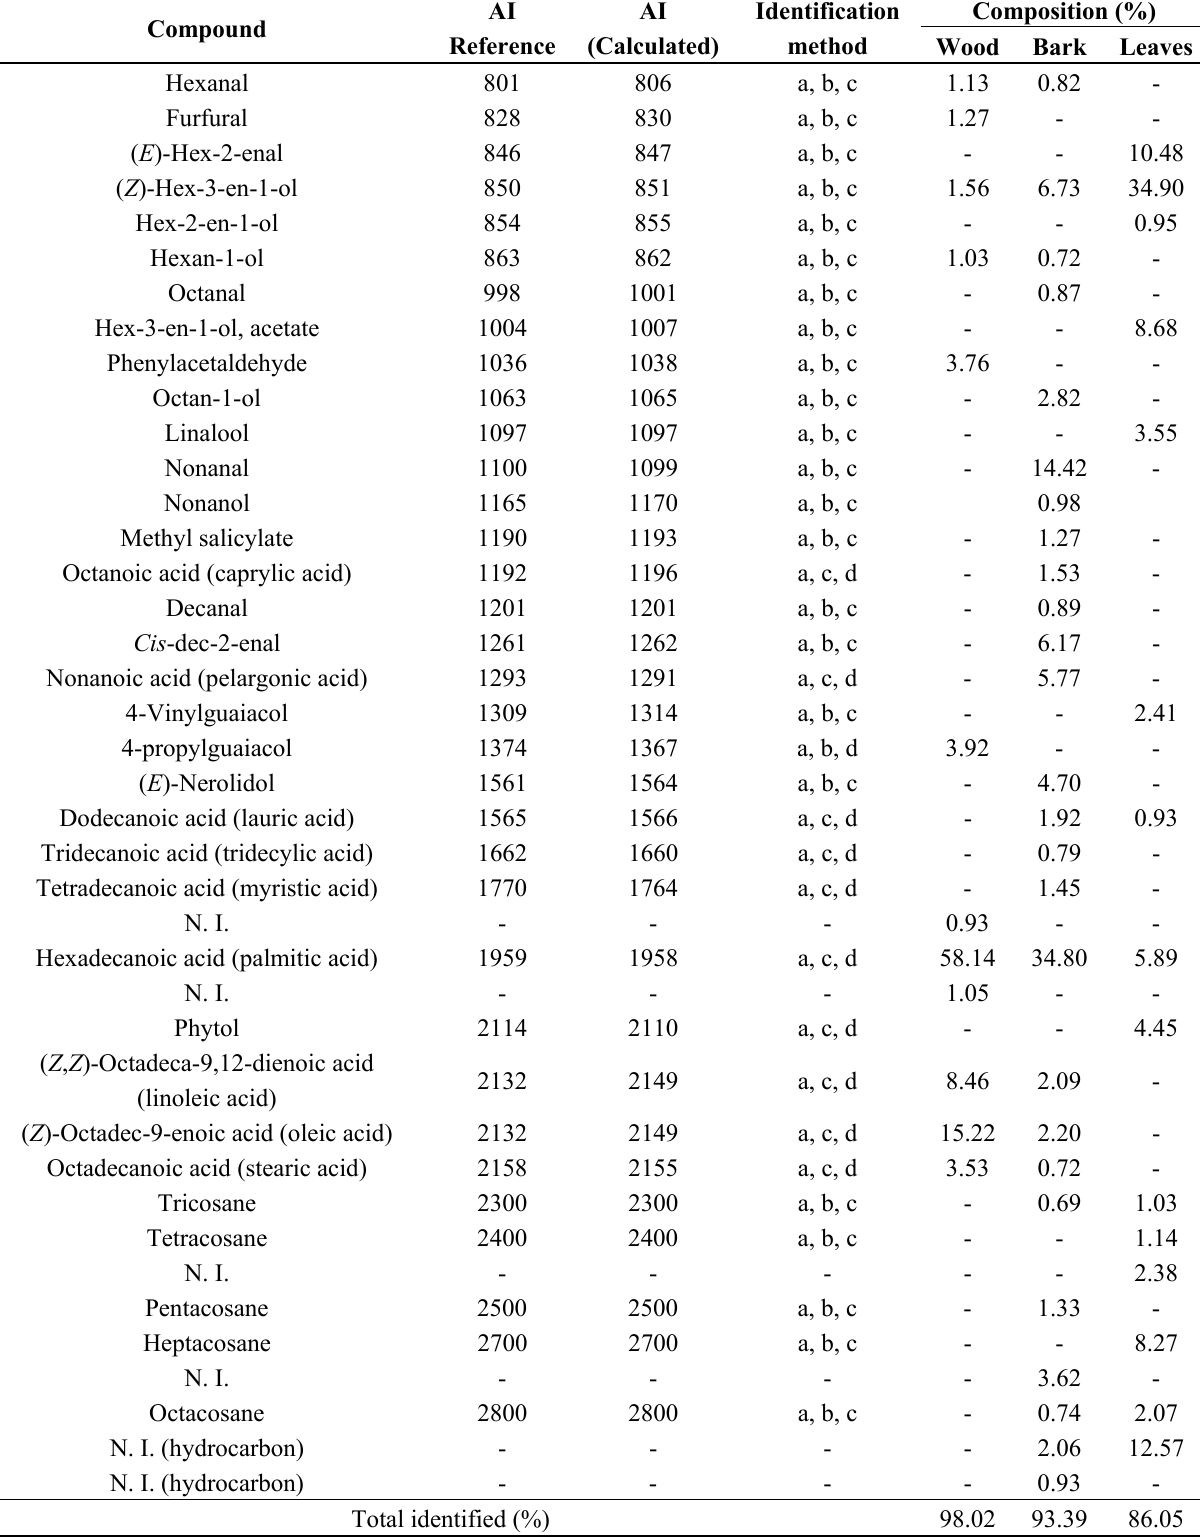
Table 1. Chemical composition of essential oil from different parts of C. bakeriana. AI Compound